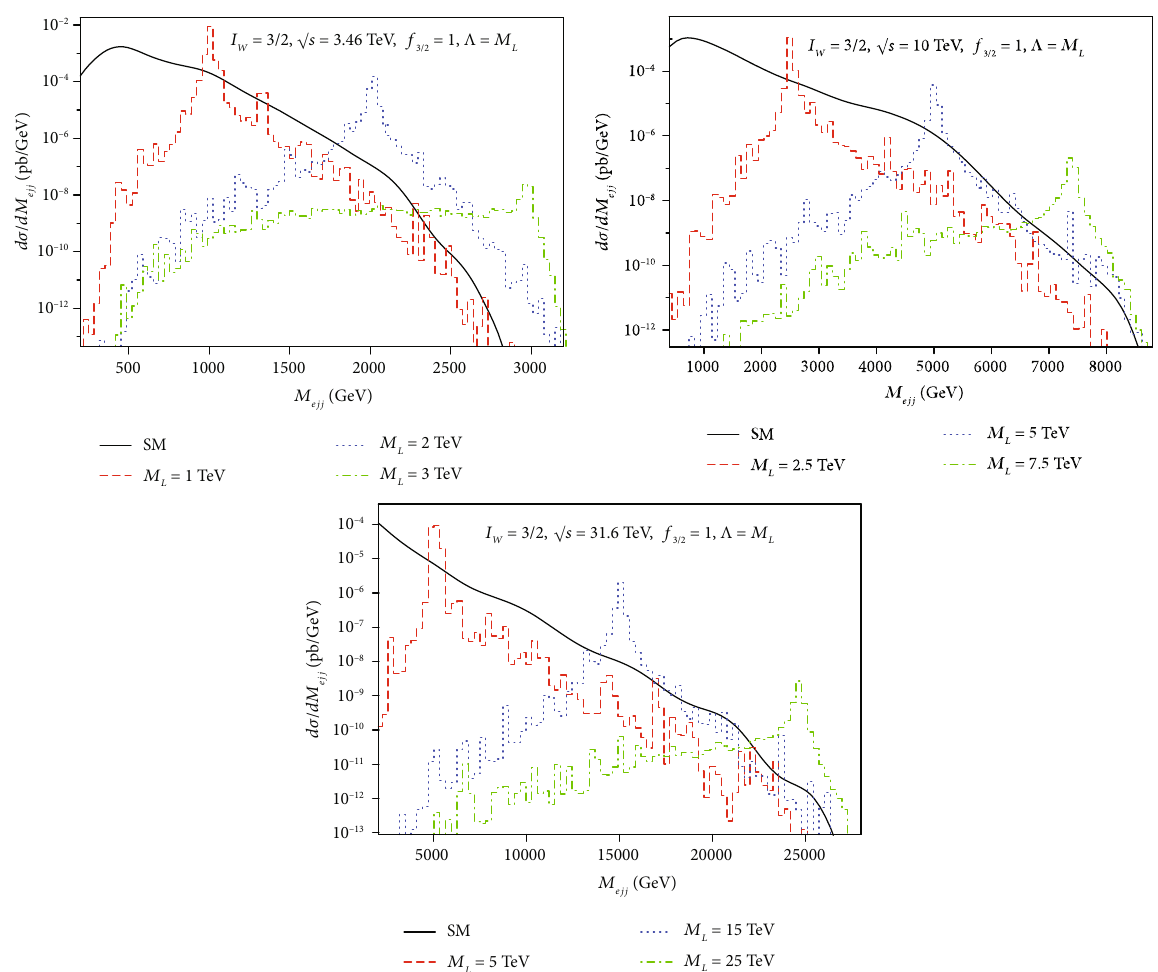
= 3/2 after the discovery W